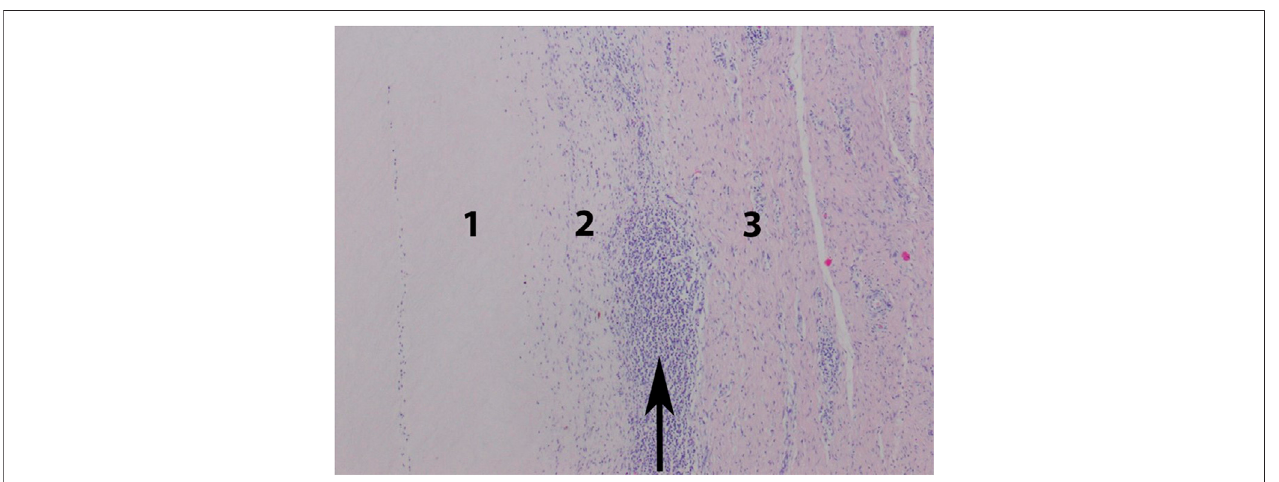
FIGURE 3 | Auricle. Resorptive reaction to the implant. Zone 1: implant, zone 2: macrophagal in fi ltration, zone 3: fi brous scar tissue. Focal nodular cluster of lymphocytes (arrow).